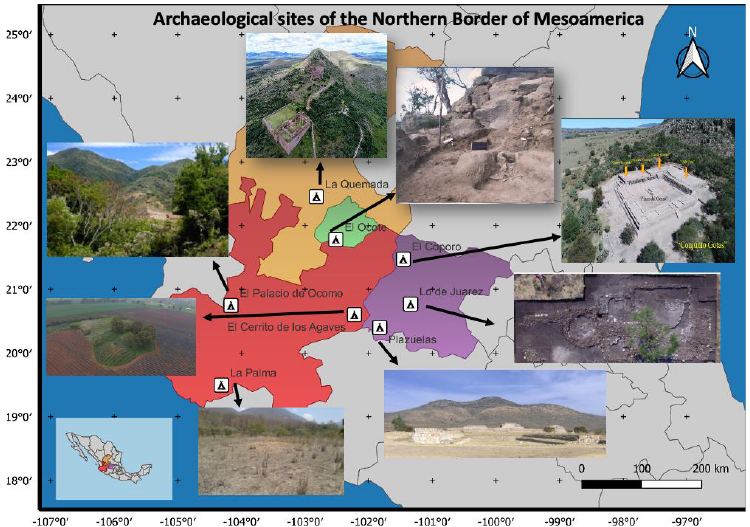
Land 2022 , 11 , x FOR PEER REVIEW 4 of 17 Figure 1. Location of the archaeological sites mentioned in the text. Figure 1. Location of the archaeological sites mentioned in the text.